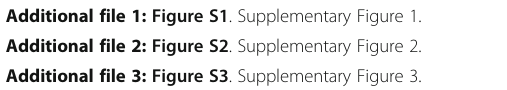
Additional file 1: Figure S1 . Supplementary Figure 1. Additional file 2: Figure S2 . Supplementary Figure 2. Additional file 3: Figure S3 . Supplementary Figure 3.